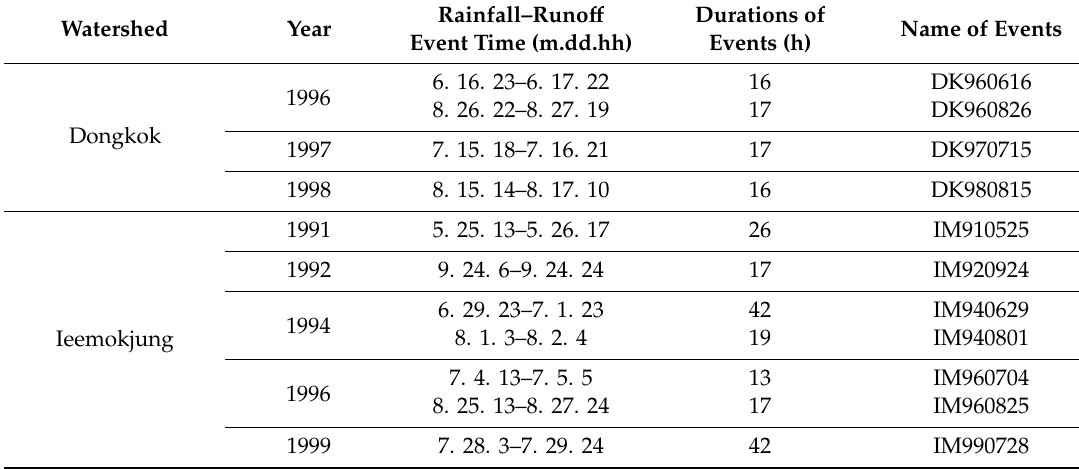
Table 2. Selected rainfall–runoff events in the TOPMODEL application.